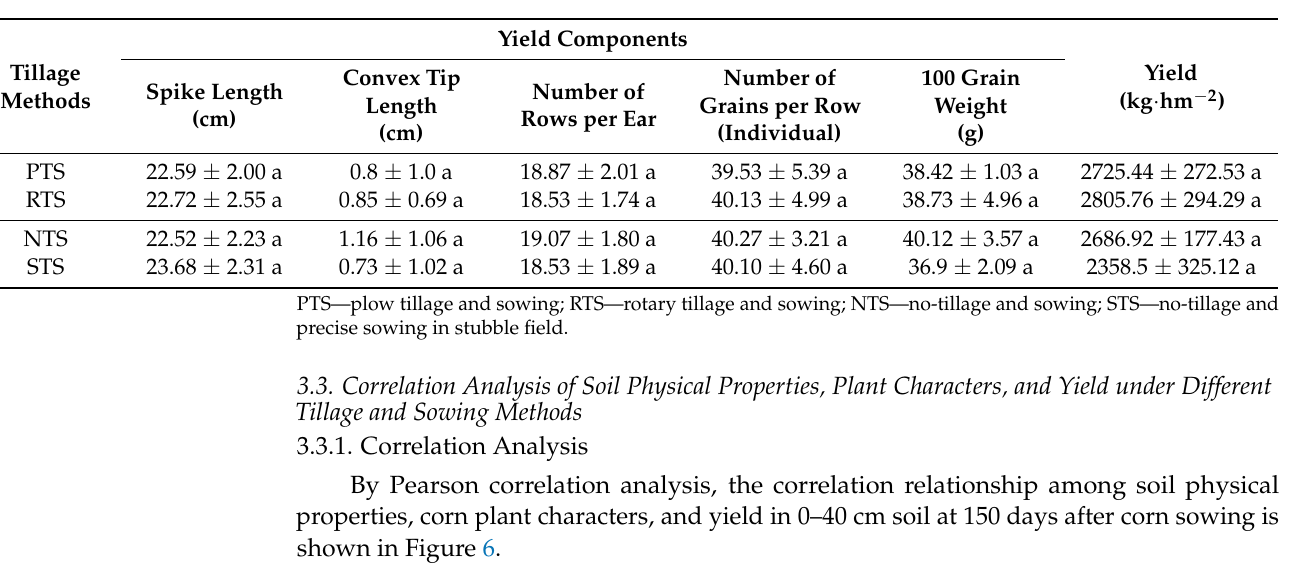
Table 4. Effects of tillage and sowing methods on corn yield.